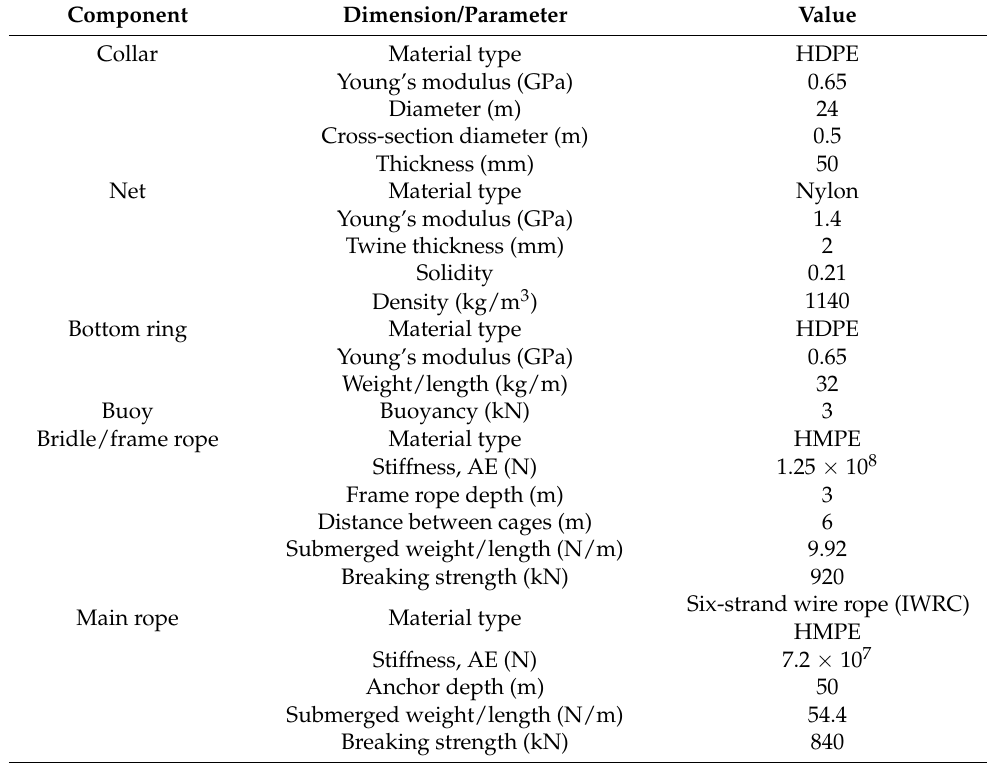
Table 2. The main dimensions and material parameters of the numerical model. Component